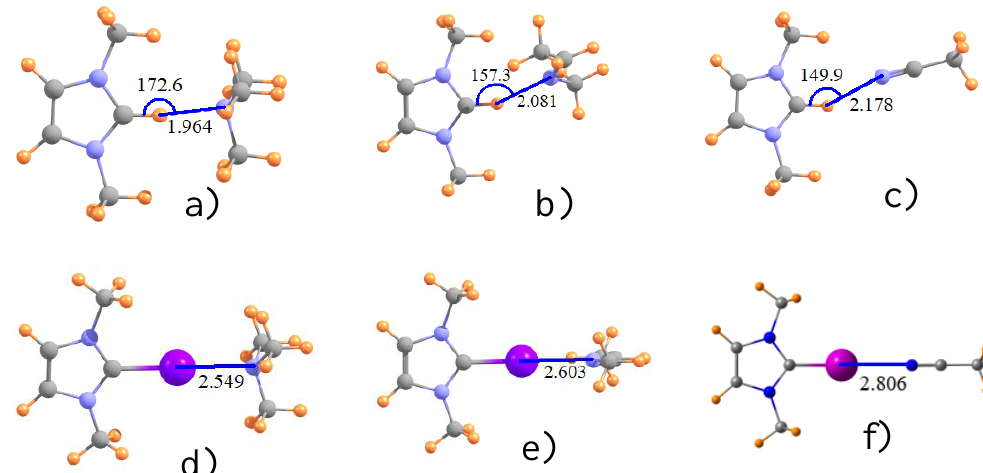
Figure 2. Optimized geometry of ImH + with ( a ) NMe 3 ; ( b ) imine MeN=CHMe and ( c ) nitrile MeCN; ( d – f ) illustrate I-substituted